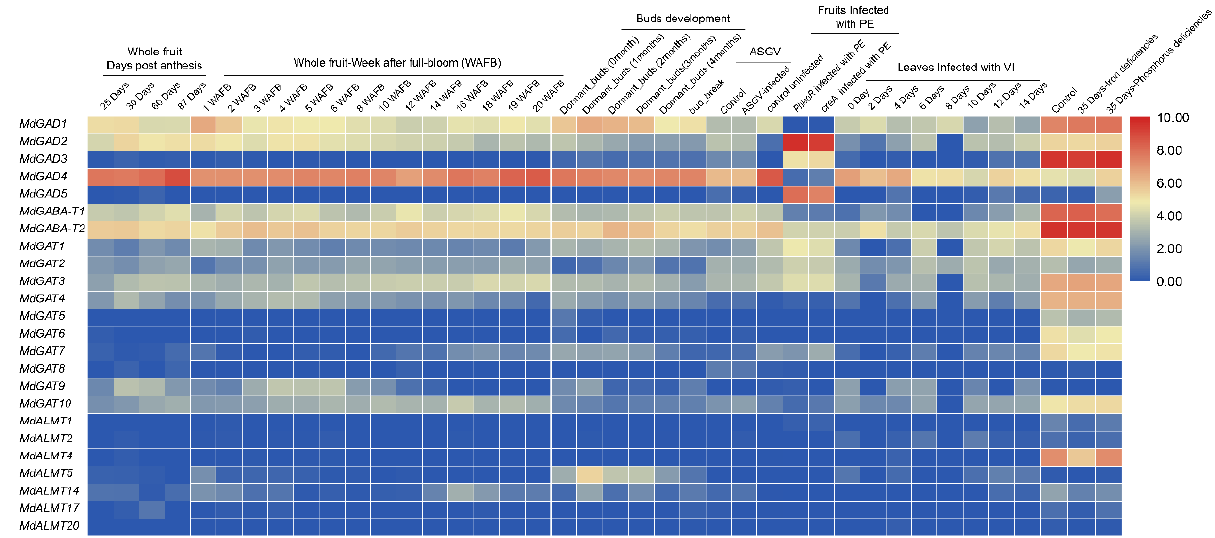
Figure 6. The expression of 24 GABA signal pathway gene involving growth and developmental process of apple were investigated use the website. Relative expression values with color blue (low) to red (high) are displayed at the bottom.